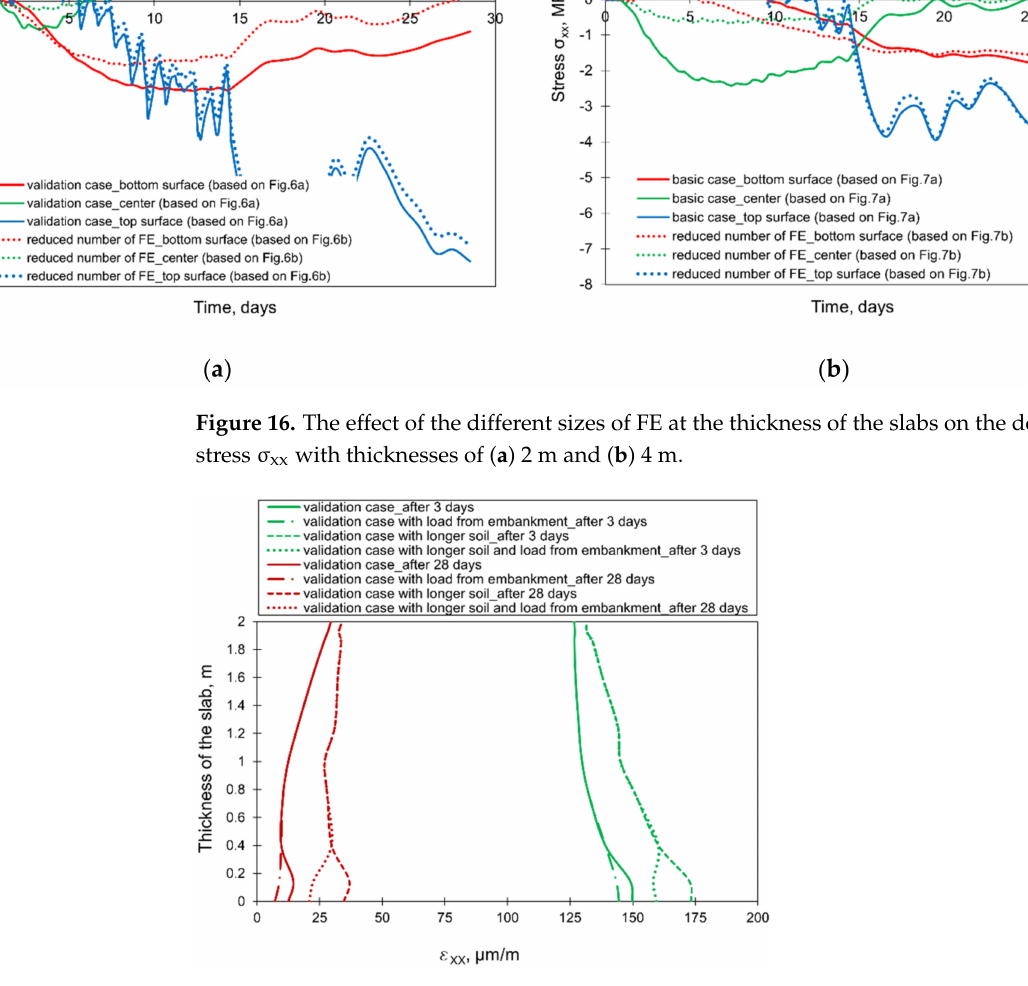
Figure 17. The effect of the different sizes of the cooperated soil on the distributions of strains ε xx at the thickness of the